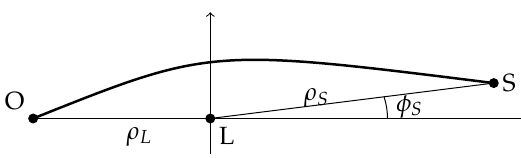
Figure A1. Scheme of lensing, with the lens at the origin of the coordinate